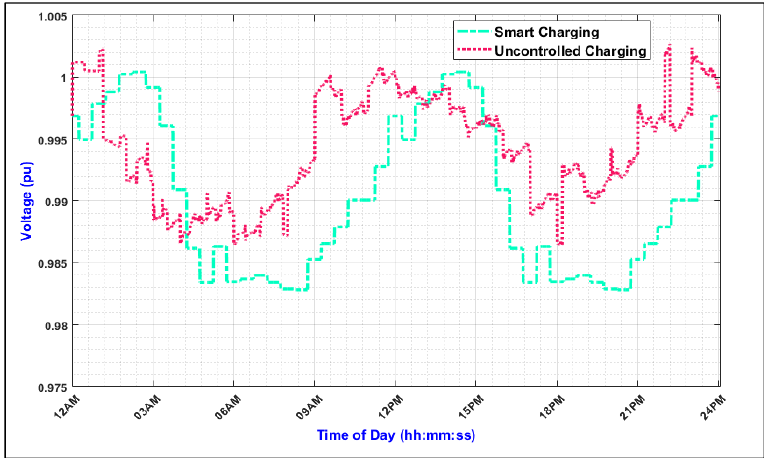
Figure 16. Voltage Waveform Measured at PCC at Node 48 When FCSs are Connected.